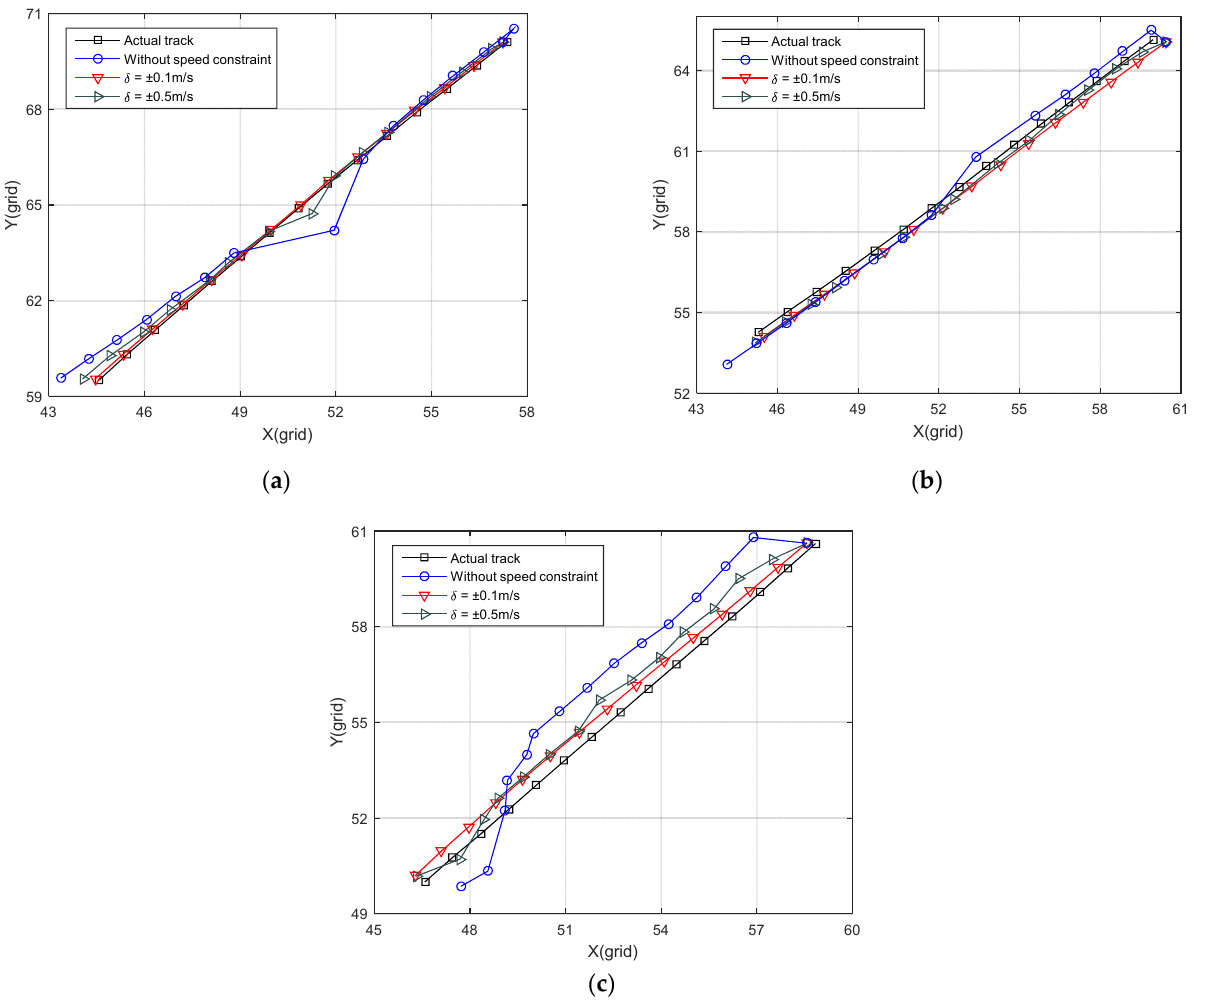
Figure 11. Comparison of speed constraint. ( a ) Matching results of the track in Section 3.1; ( b ) Match- ing results of the track in Section 3.2; ( c ) Matching results of the track in Section 3.3.